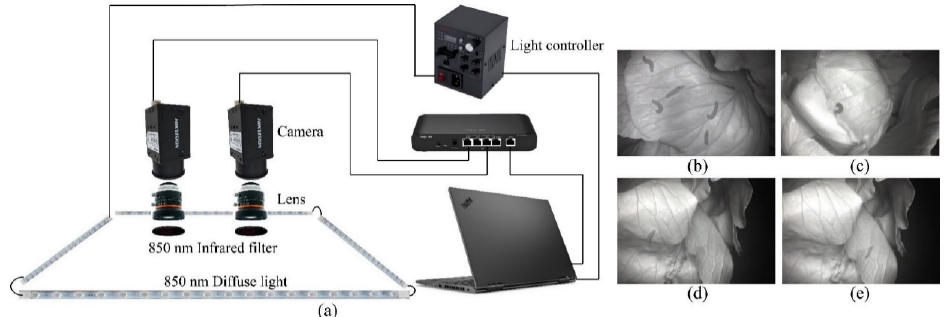
Figure 2. The binocular NIR vision unit and the example of collected images. ( a ) The visual system composition. ( b – e ) Regular cabbage as background and P. rapae larvae in different positions and postures taken from the collected NIR images.